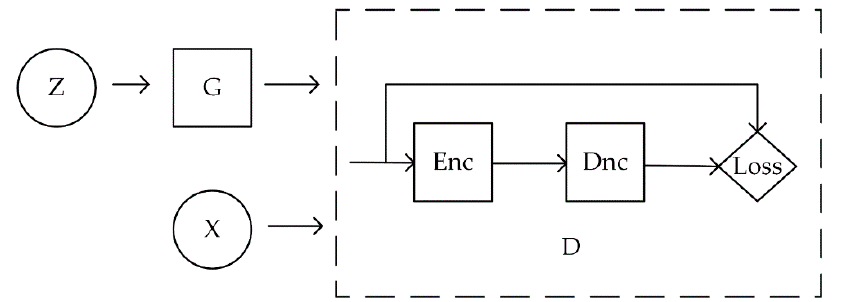
Figure 1. BEGAN network structure.